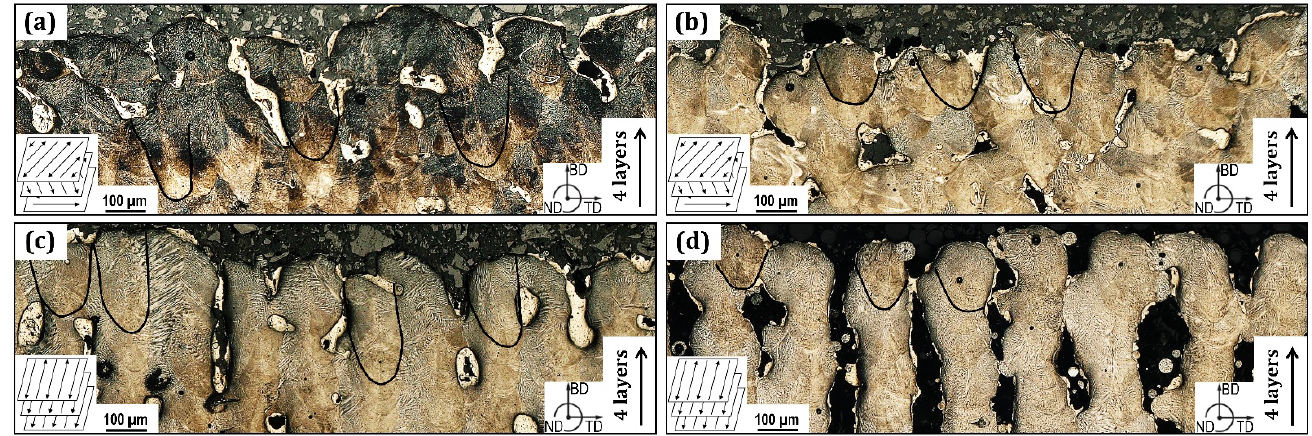
Figure 3. LM of etched cross-sections of top surfaces with enrichment of AgCaLa: ( a ) HD, ( b ) LD, ( c ) HD-0, AgCaLa phases between adjacent melt pools, narrow shape of melt pools, ( d ) LD-0.